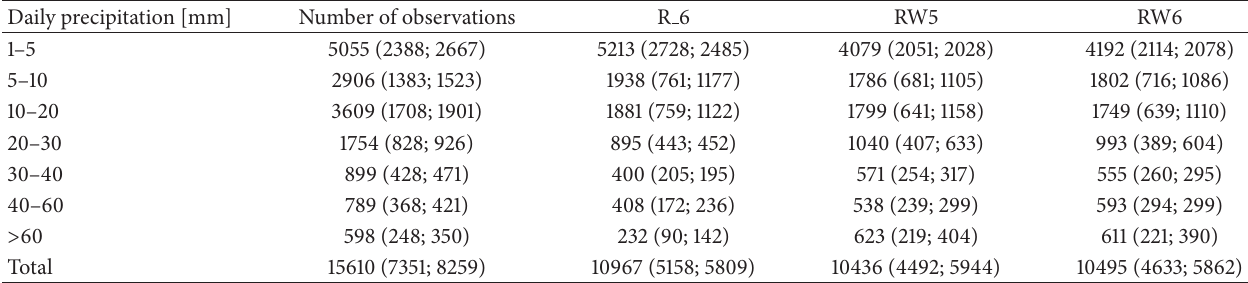
Table 3: Number of occurrences for different daily precipitation intervals for observations, R 6, RW5, and RW6. The numbers in parentheses show the reports in a given precipitation interval below (valley) and above (hill-mountain) 400m, respectively.